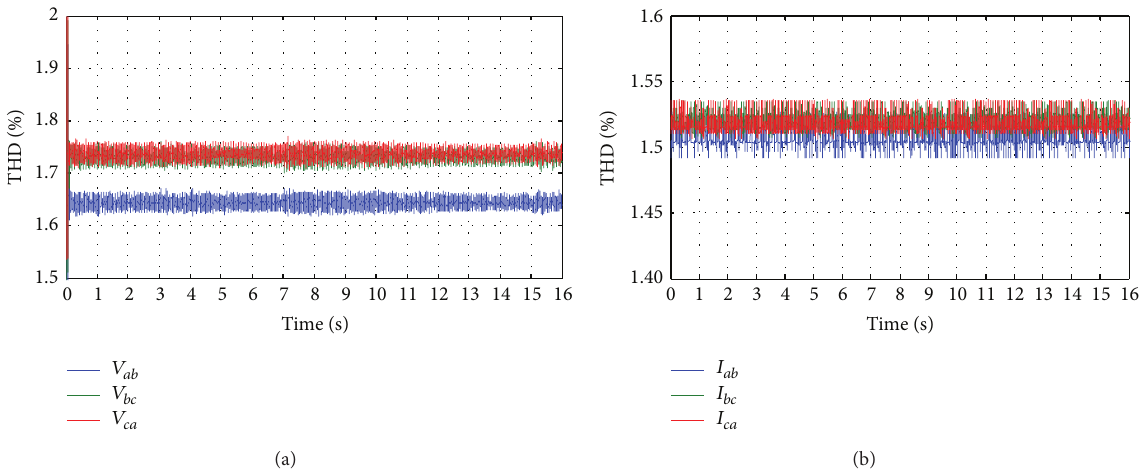
Figure 26: The total harmonic distortion throughout the whole simulation time. (a) THD of line voltage; (b) THD of line current.